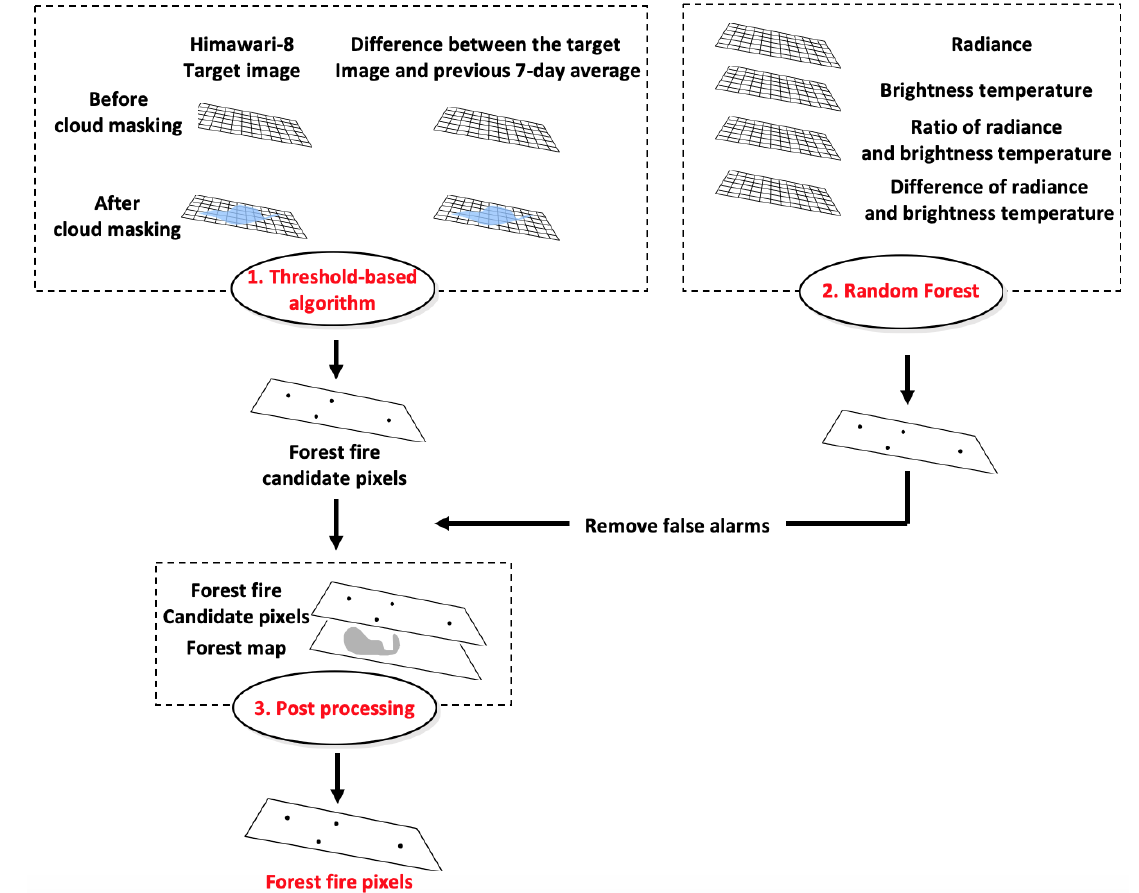
Figure 2. The process flow of detecting forest fire pixels based on the threshold-based algorithm, machine learning, and post-processing approaches. 205